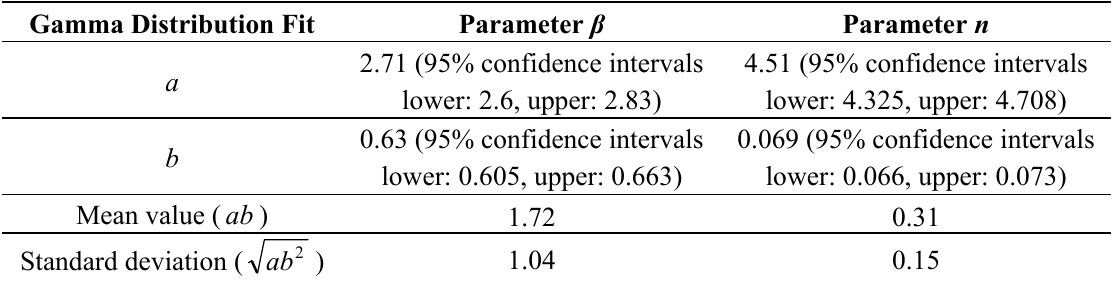
Table 2. Parameters a and b of the Gamma distribution (including the 95% confidence intervals) and the estimated parameters β and n